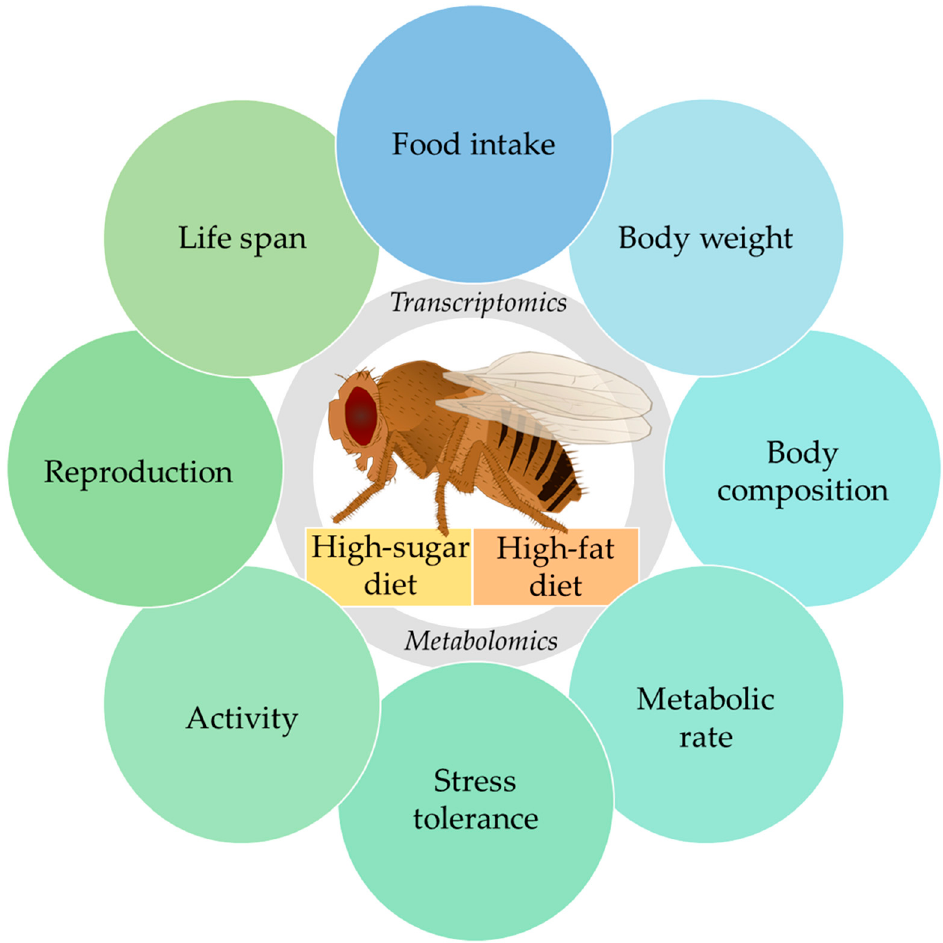
Figure 16. Overview of the methodological tool box that can be applied to study the responses of Drosophila melanogaster to high-sugar or high-fat diets from the molecular level to phenotypical traits. Using D. melanogaster as a model organism has merits but also some limitations. First, not all organ and tissue structures of the fruit fly are functionally equivalent to those of humans and other mammalian species and some are even lacking. For instance, the fruit fly has only an innate immune system, which excludes studies of the response of the adaptive immune system to changing environmental factors such as microbial